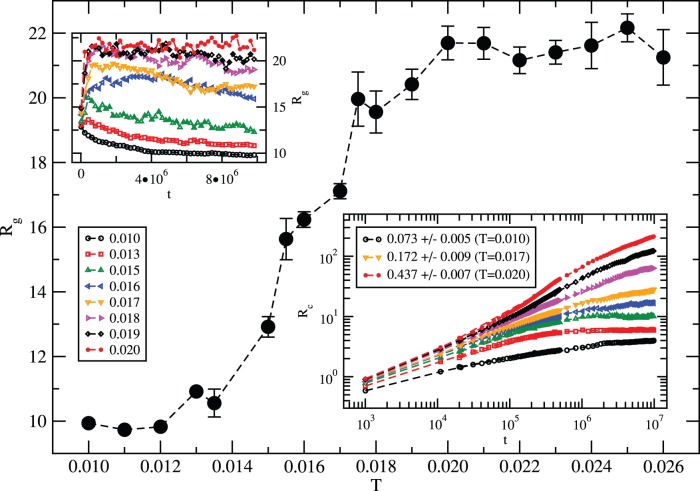
Variation of the average radius of gyration (Rg) of histone H3.1 with temperature using MJ potential.Simulations are performed for t = 107 MCS time on a 643 lattice with 150 independent samples; 1000 samples are used with shorter runs. Insets: top left: Rg versus t; bottom right: RMS displacement (Rc) versus t on a log-log scale with asymptotic slopes at T = 0.010, 0.017, 0.020.